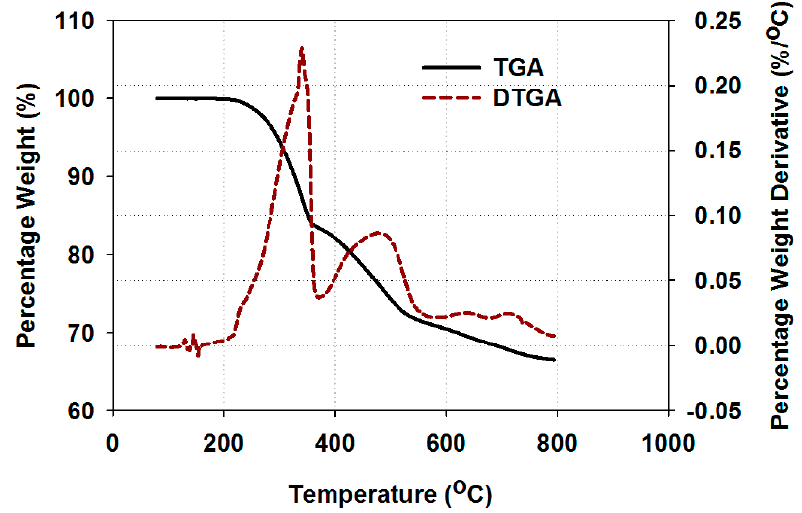
Figure 4. TGA-DTGA of RTV silicone rubber filled with ATH to 50 wt.%, performed in Nitrogen atmosphere under a temperature ramping protocol between 80 and 800 °C at a rate of 10 °C/min.